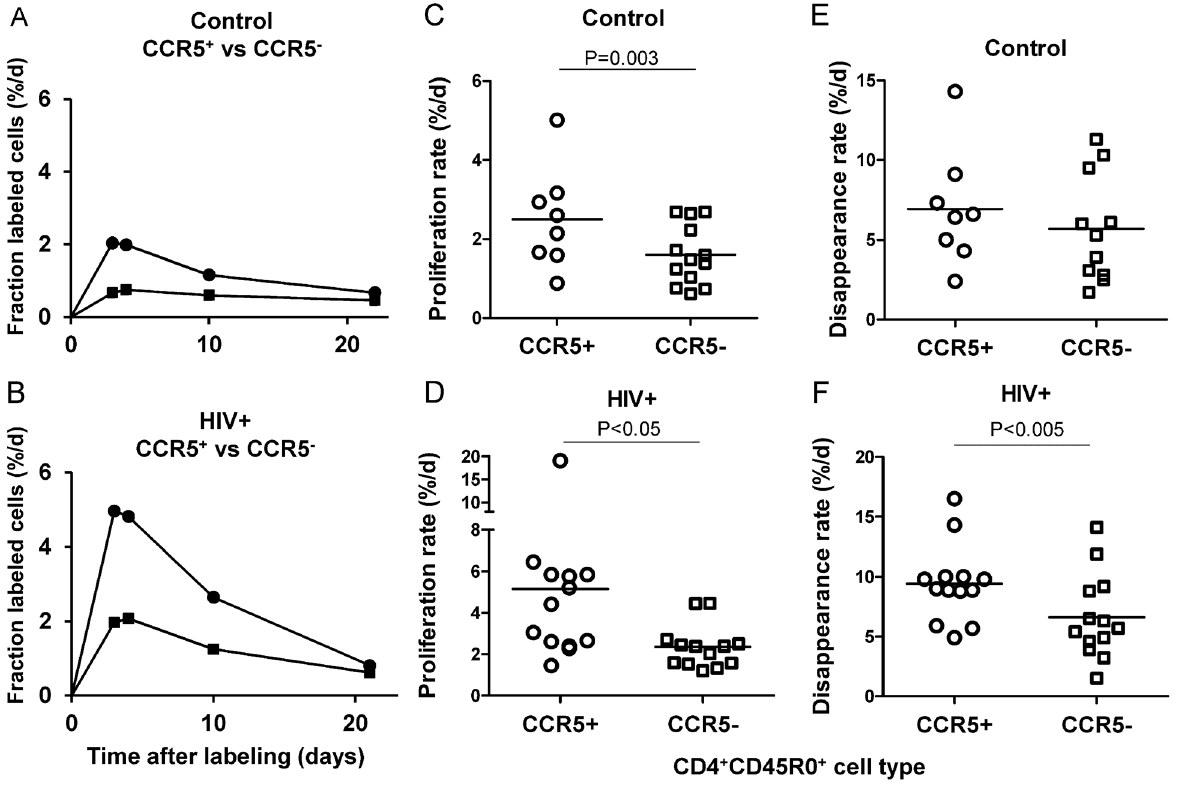
Figure 1. Relationship between CCR5 expression and proliferation, disappearance and phenotype in CD45R0 + CD4 + memory T- cells. (A,B) Deuterium enrichment plots expressed as fraction of labeled CD45R0 + CD4 + memory T-cells from a one-day labeling experiment. Cells are compared according to CCR5 expression: circles, CCR5 + ; squares, CCR5 2 . Representative data are shown from one typical control subject (A) and one HIV-positive subject (B). Modeled proliferation (C, D) and disappearance (E, F) rate constants for CD45R0 + memory CD4 + T-cell subsets defined by CCR5 expression in healthy (C,E) and HIV + (D,F) subjects. Symbols denote cell type: circles, CCR5 + ; squares, CCR5 2 ; horizontal bar, mean, P values by paired